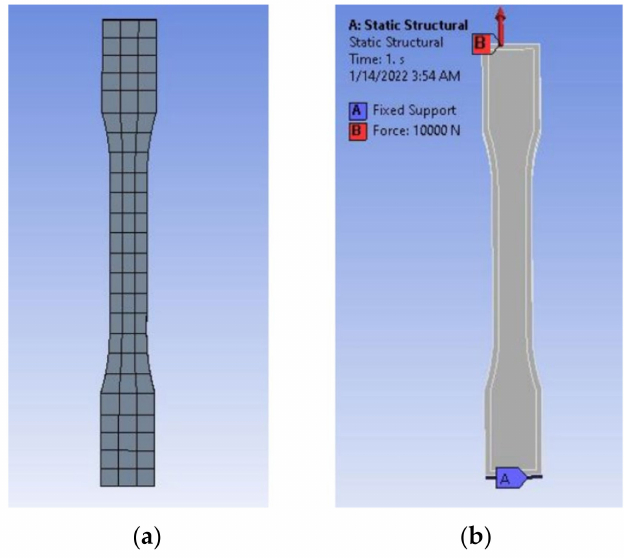
Figure 5. ( a ) Meshing of the specimen and ( b ) boundary and loading conditions of 10 kN.